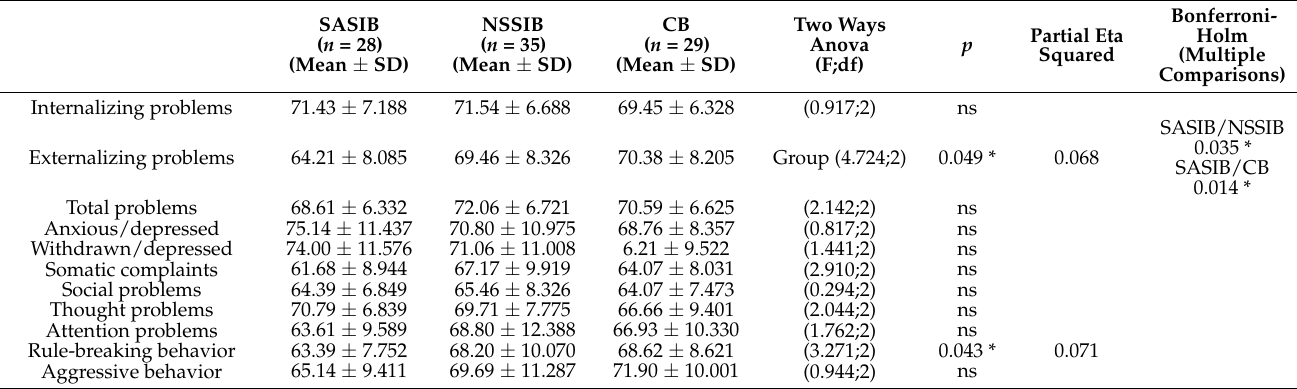
Table 1. Two-way ANOVA corrected by gender: Comparison between the three groups according to the Child Behavior Checklist (CBCL) (parent reports).